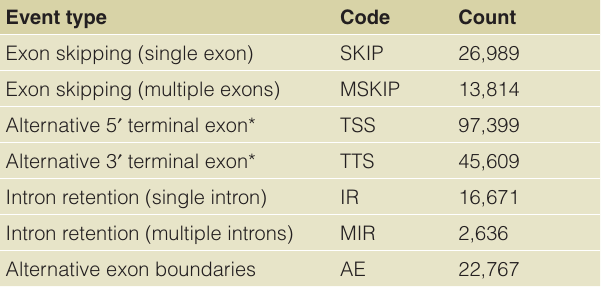
Table S5. Numbers of candidate alternative splicing events found in the Illumina Human Body Map data, by type.